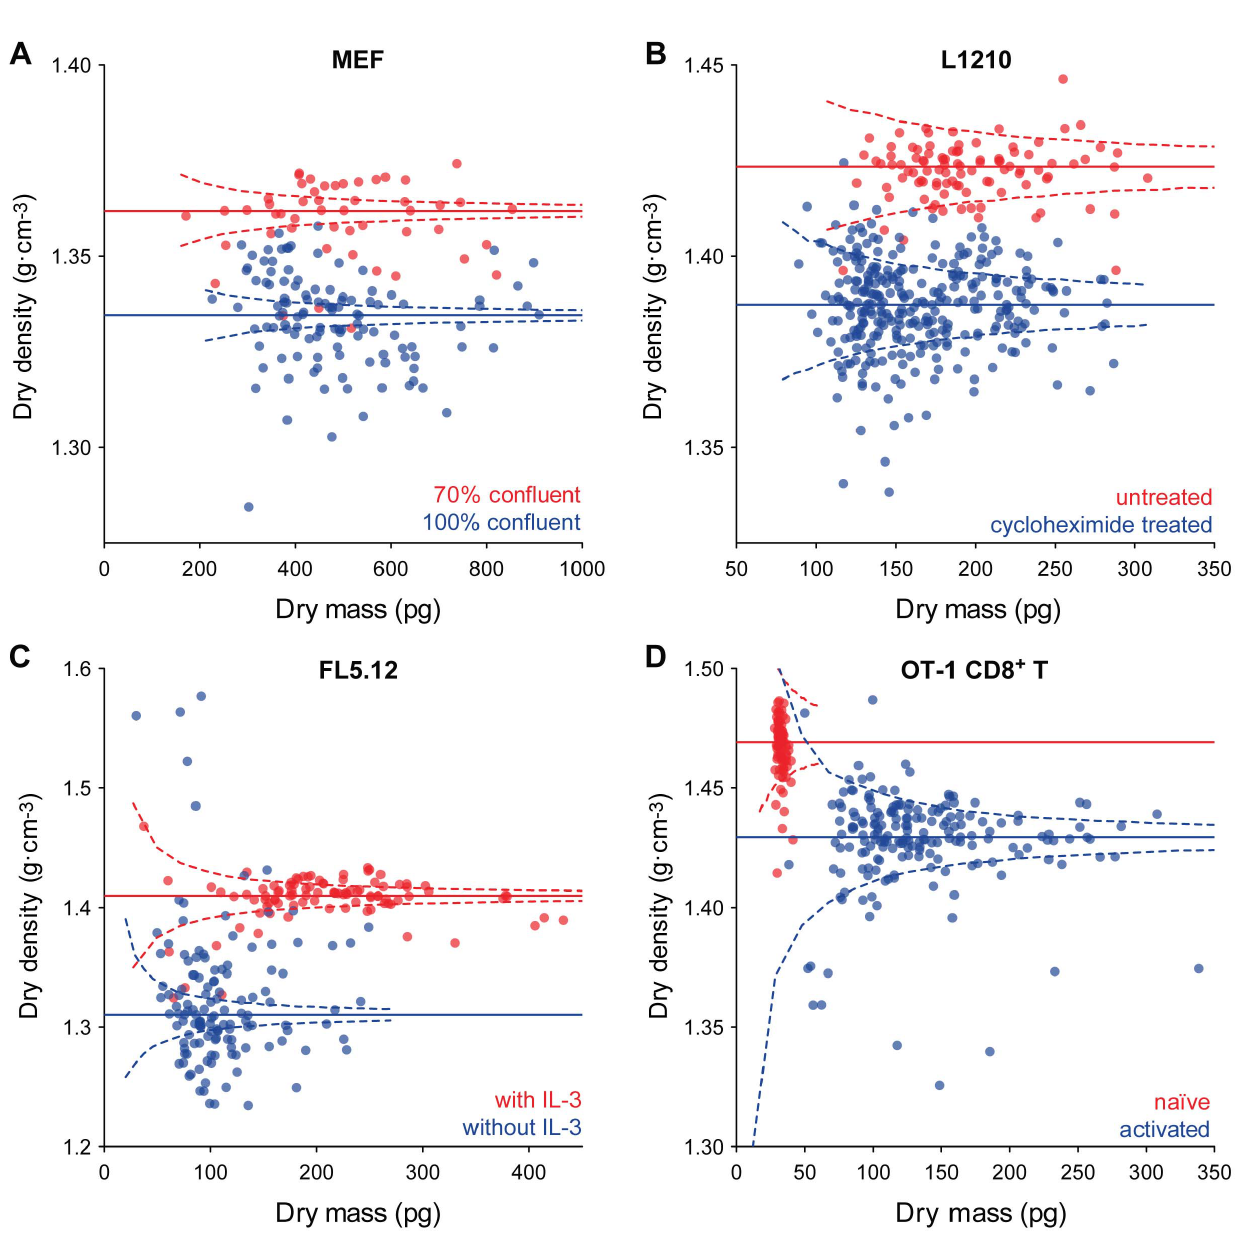
Figure 4. Dry density and mass of proliferating and non-proliferating mammalian cells. Solid lines are median dry densities and dashed lines are 99% bounds on the expected dry densities if all cells actually had the median dry density, given known measurement error. a) Confluent and proliferating (75% confluency) mouse embryonic fibroblasts. b) Cycloheximide-treated and proliferating L1210 cells. c) IL-3-depleted and proliferating FL5.12 cells. d) Naı¨ve and activated OT-1 T cells.